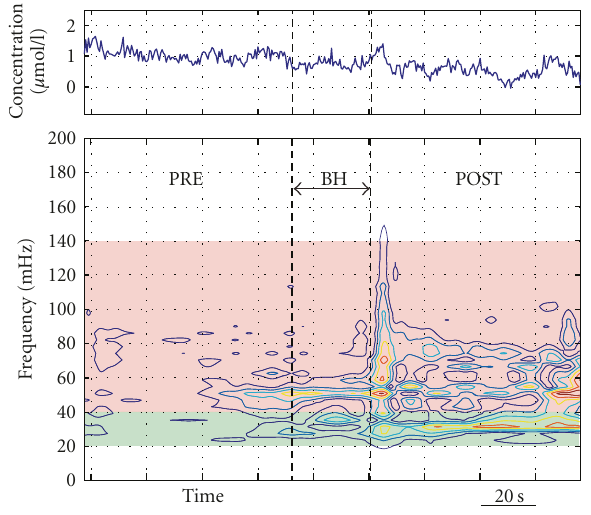
Figure 2: HHb concentration signal (upper panel) recorded on a healthy woman before (PRE), after (POST) and during breath- holding (BH). The vertical dashed lines mark the onset and o ff set of the BH. the Lower panel shows the 6-levels contour plot of the Choi-Williams time-frequency distribution of the signal ( σ = 0 . 05). The red rectangle indicates the LF band (40–140 mHz), the green the VLF band (20–40 mHz). In this subject, there is a neat increase of the VLF and LF power after BH (POST region).